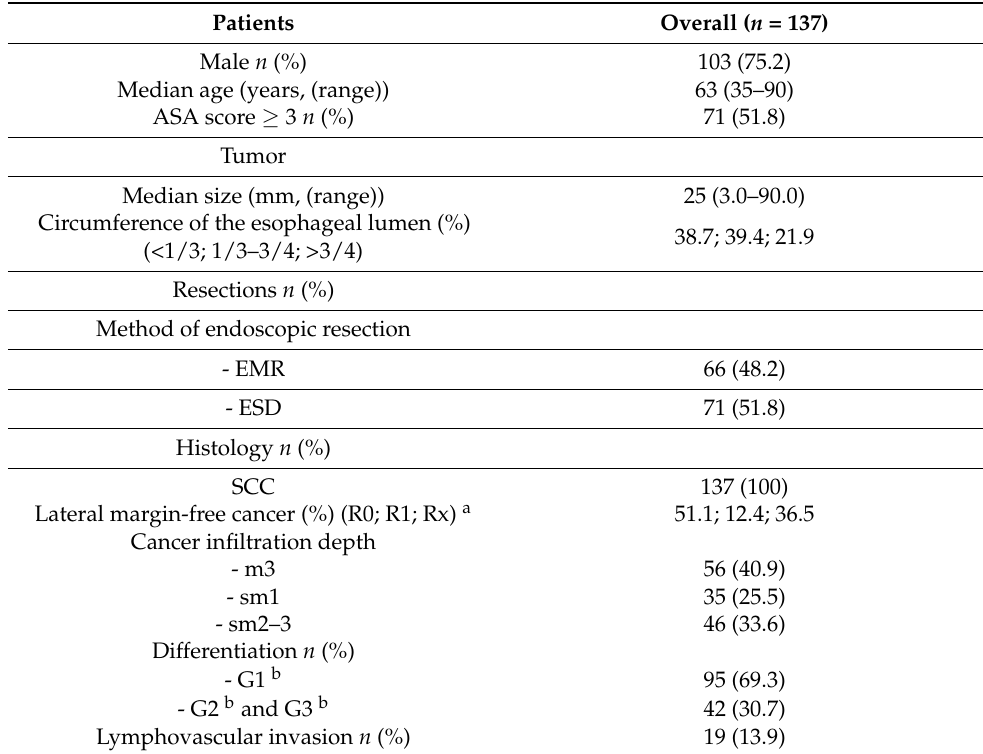
Table 1. Tumor characteristics ( n =